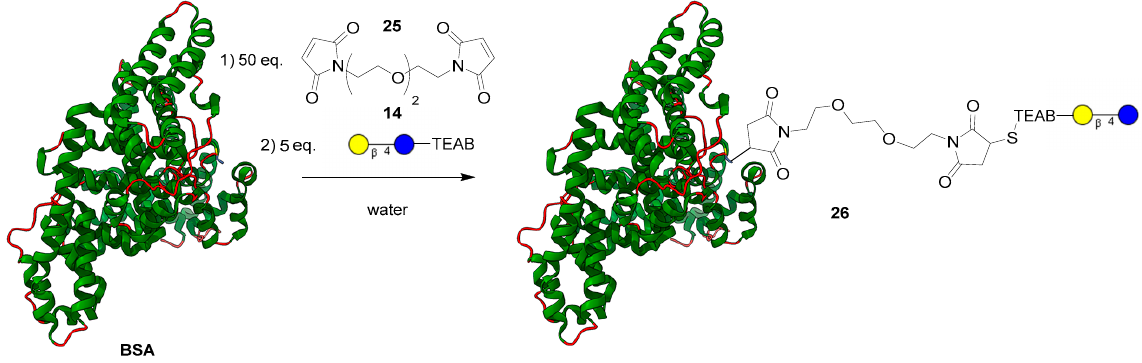
Figure 5. Attachment of bifunctional maleimide linker and lactose-TEAB ( 14 ) to BSA.